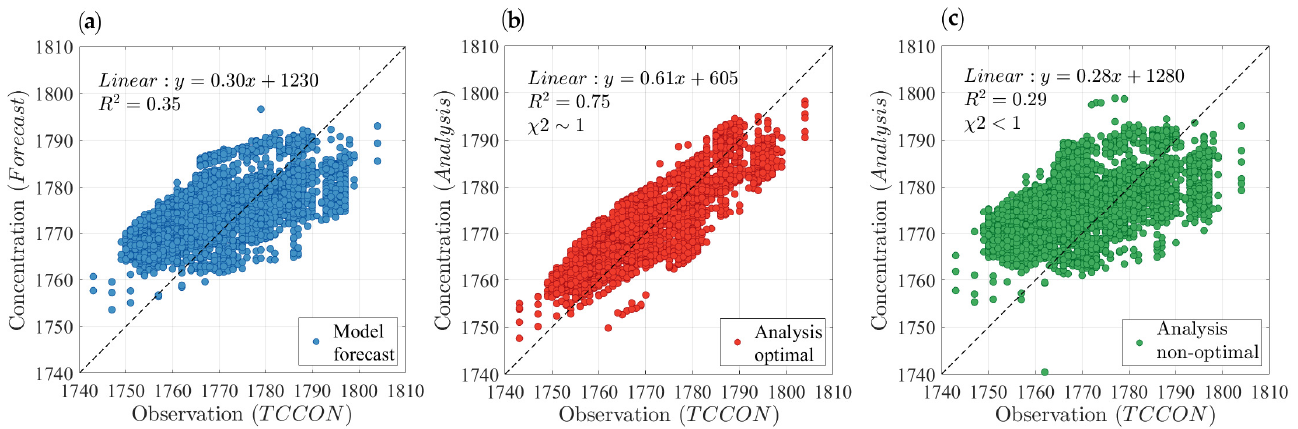
Figure 8. ( a ) Comparison of model forecast (blue circles), ( b ) analysis with optimal parameters (red circles), and ( c ) analysis with nonoptimal parameters (green circles) against independent TCCON observations. Optimal parameters of the analysis include f o = 0.5, f i = 0.45, f q = 0.018, L h = 350 km, L v = 7 σ and the nonoptimal parameters are assumed to be f o = 1.2, f i = 0.45, f q = 0, L h = 600 km, L v = 1 σ